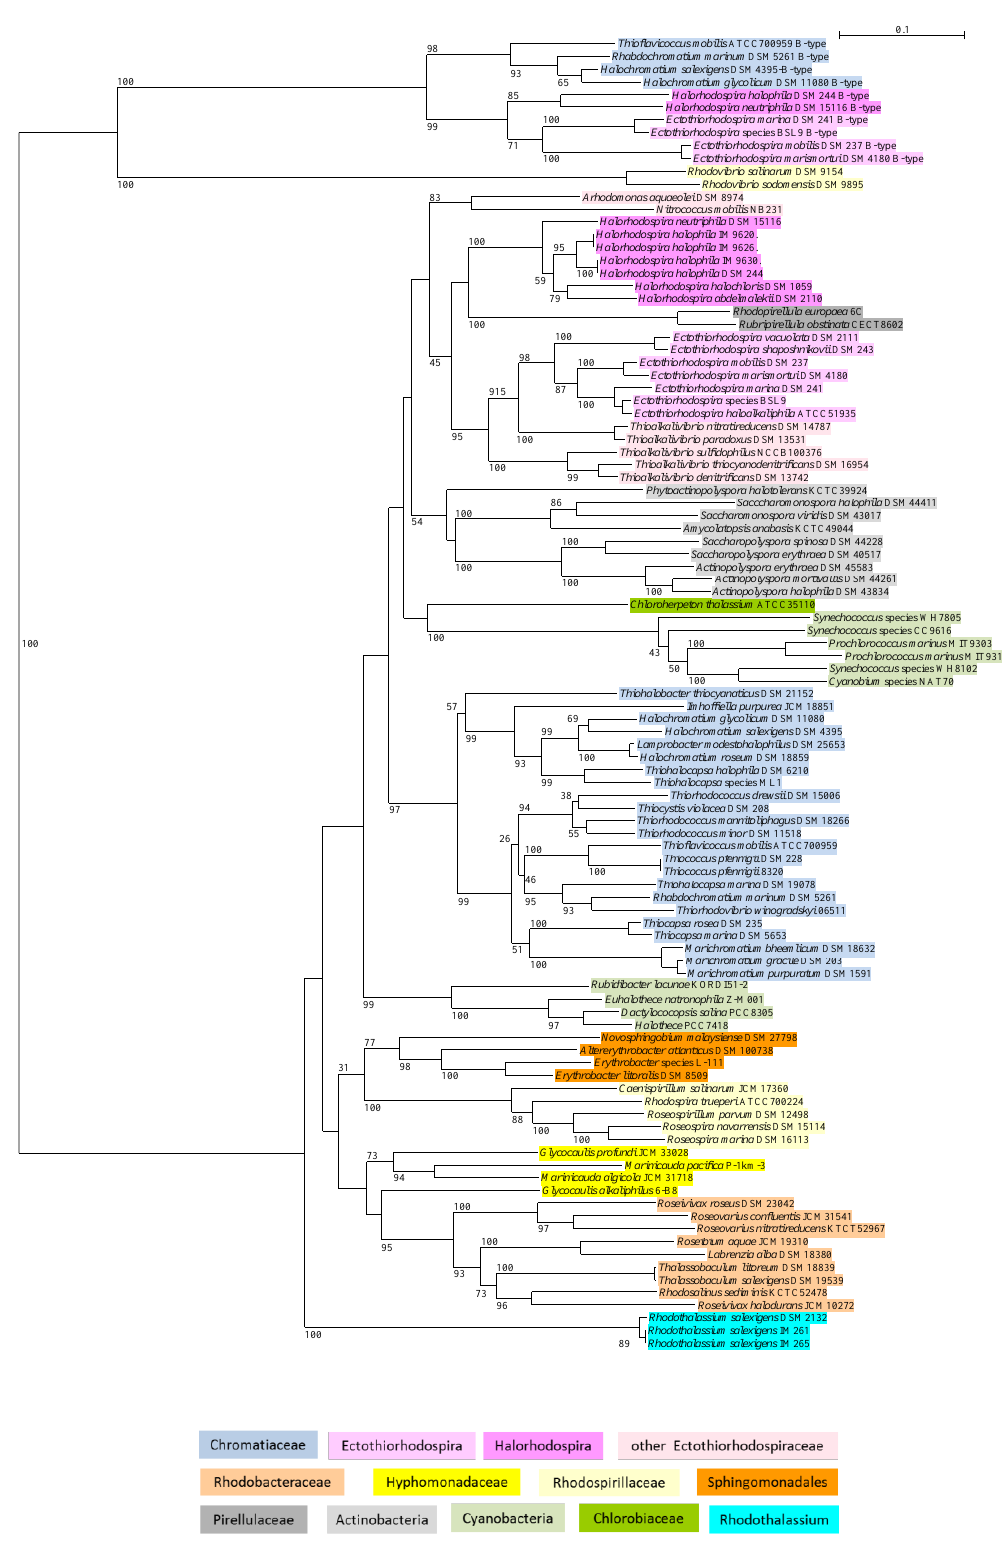
Figure 1. The phylogeny of betaine biosynthesis based on the sequences of glycine/sarcosine methyltransferase GMT is shown in a neighbor-joining tree. Sequences and gene bank accession numbers are shown in the Supplementary Table S1. Bootstrap values expressed as percentages of 1000 replications are given at the branches. The bar indicates an evolutionary distance of 0.1. The following color code highlights the different systematic